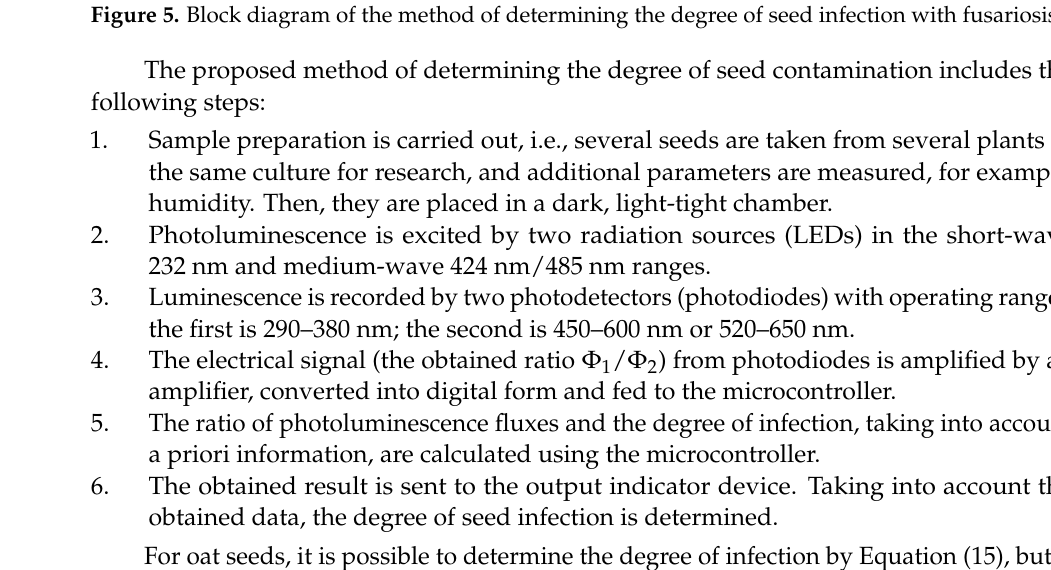
Figure 5. Block diagram of the method of determining the degree of seed infection with fusariosis.